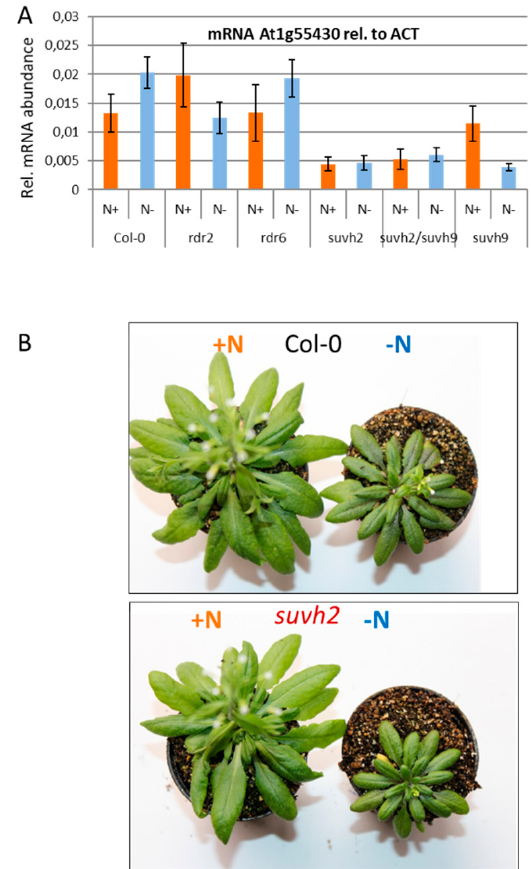
Figure 8. Analysis of selected mutants for RNA directed RNA polymerase (RDR) function and histone methyltransferase (SUVH) function under limited N conditions. ( A ) mRNA abundance of AT1G55430 in selected mutants for RDR function and SUVH function on +N (orange) and − N (blue), determined by real-time qPCR, relative to ACTIN11 mRNA in root tissue. Bars indicate the means of 6 biological replicates (3 technical replicates) with standard deviations. ( B ) Representative pictures of plants grown under +N (left/orange) and − N (right/blue) conditions in a vermiculite-based substrate. Shown are representative plants of the Arabidopsis thaliana accession Col-0 , and the T-DNA insertion mutant suvh2 grown for 44 days on a 70% vermiculite/30% soil mixture supplemented with Estelle and Somerville solution to achieve +N (9 mM nitrate) and − N (0.4 mM nitrate) conditions.